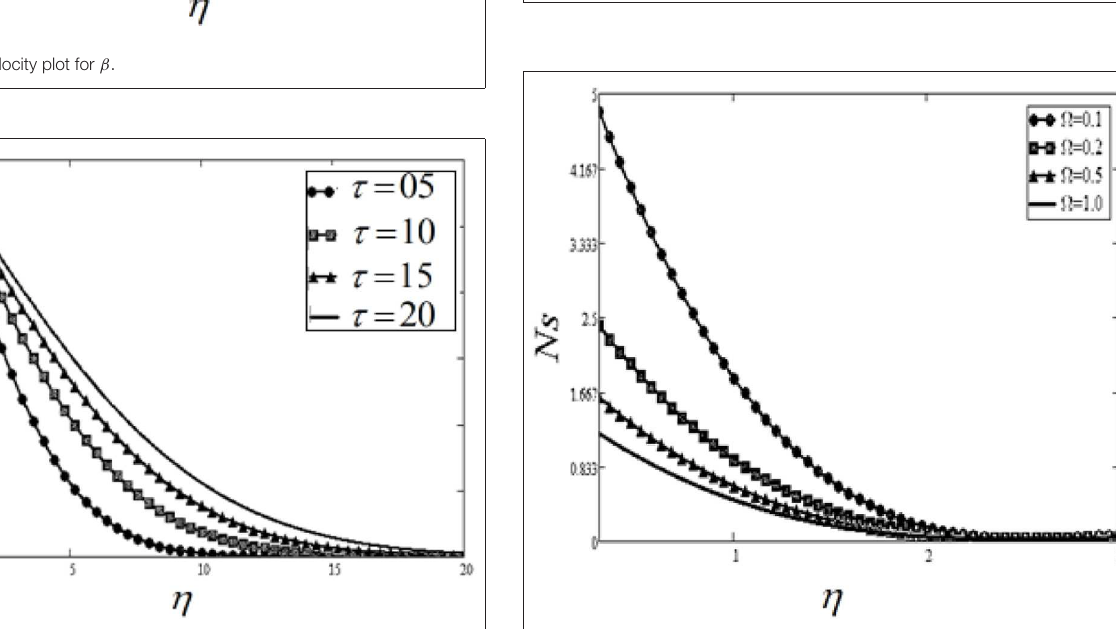
FIGURE 6 | Entropy generation plot for (cid:127)